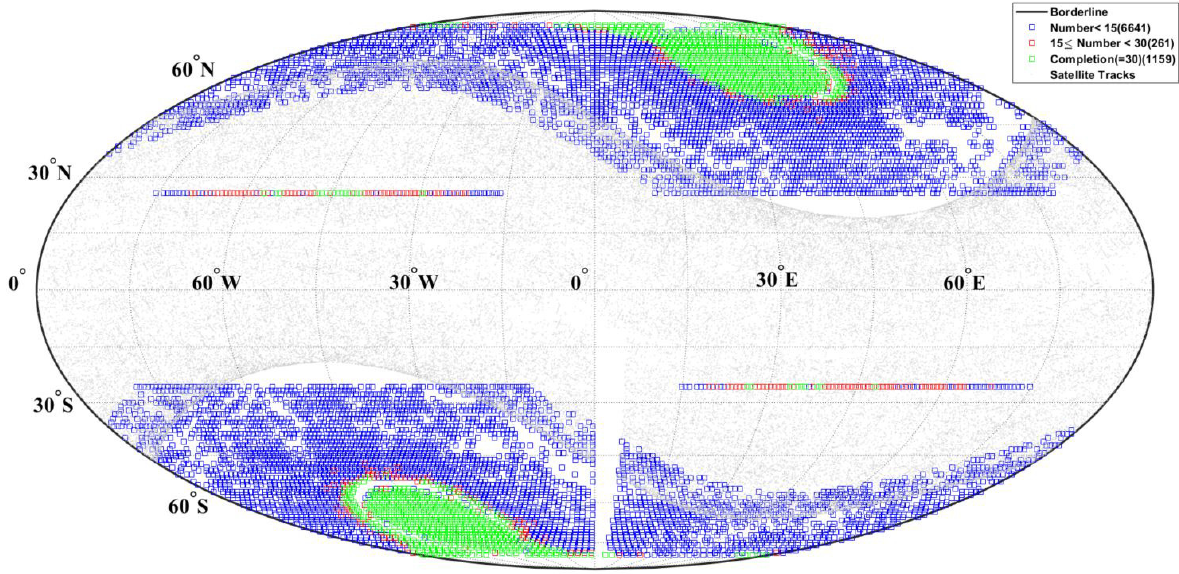
Figure 8. The results of the first year of sky surveys, with different colors representing different numbers of